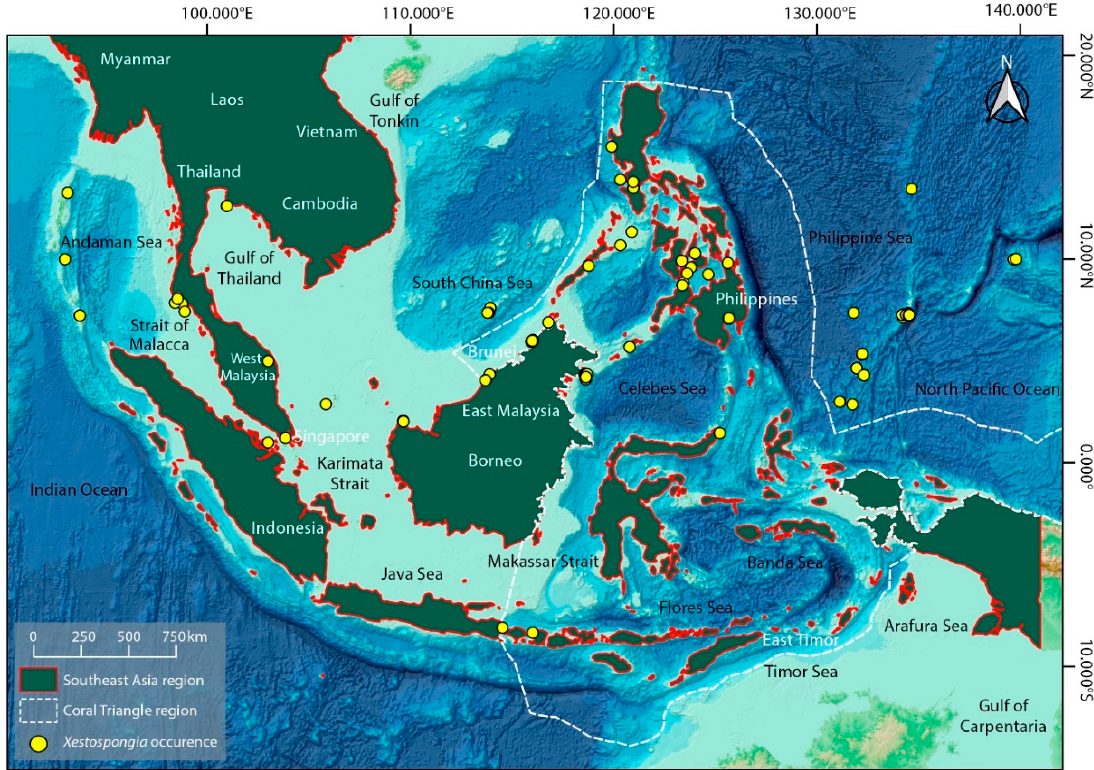
Figure 3. The location of Xestospongia spp. in Southeast Asia is indicated on the map. Malaysia, Indonesia, Thailand, Myanmar, Vietnam, Cambodia, Brunei, Singapore, Timor-Leste, and the Philip- pines are the nations that makeup Southeast Asia. Data for Xestospongia spp. (Yellow dots) are taken from the Ocean Biodiversity Information System (OBIS) (https://obis.org/; accessed on 25 December 2022) and recreated as a distribution map from the GEBCO World Map 2014. (www.gebco.net; ac- cessed on 25 December 2022).